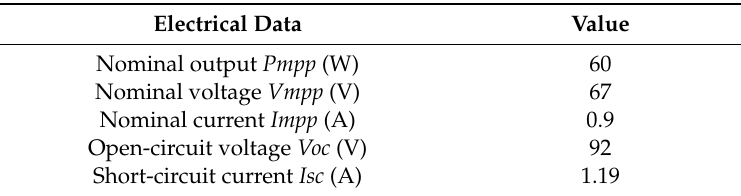
Table 3. Parameters of the KANEKA 60.